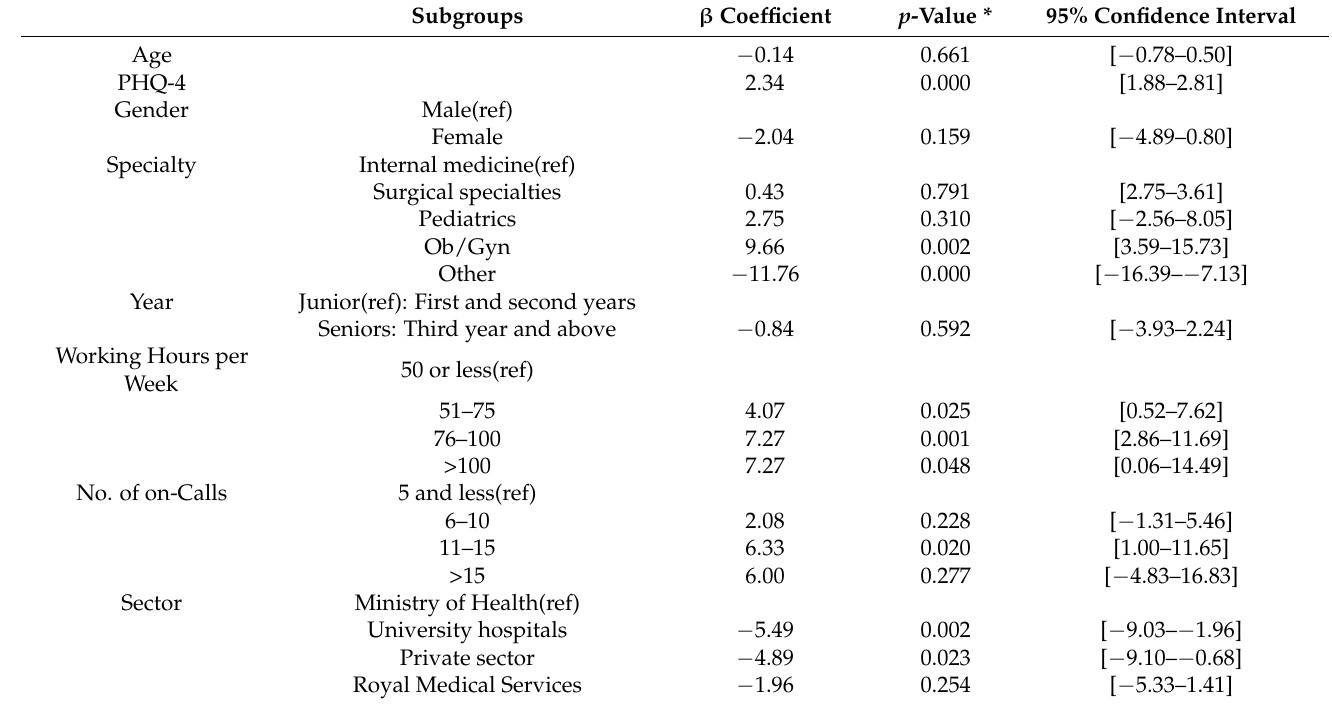
Table 3. Multivariable linear regression analysis assessing factors associated with CBI burnout